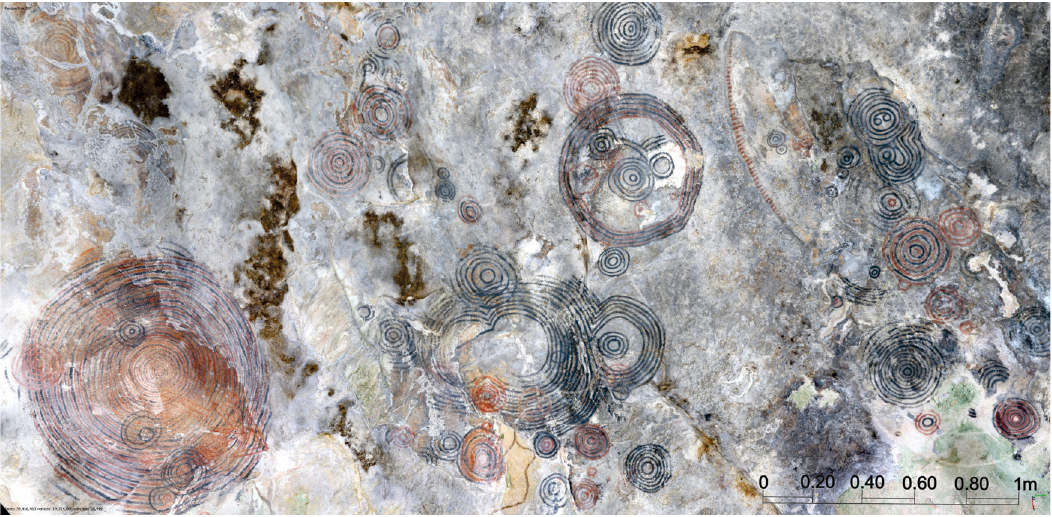
Figure 2: Partial 3D reconstruction of the Cueva No. 1 de Punta del Este, Isla de la Juventud,